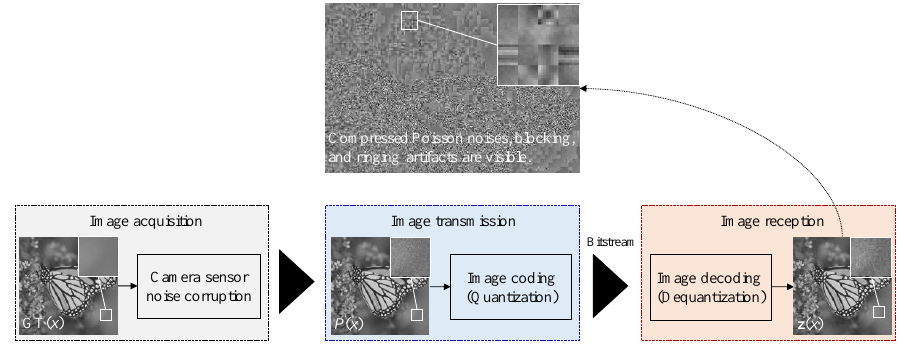
Figure 2. Image degradation model owing to the coding of Poisson noisy images.